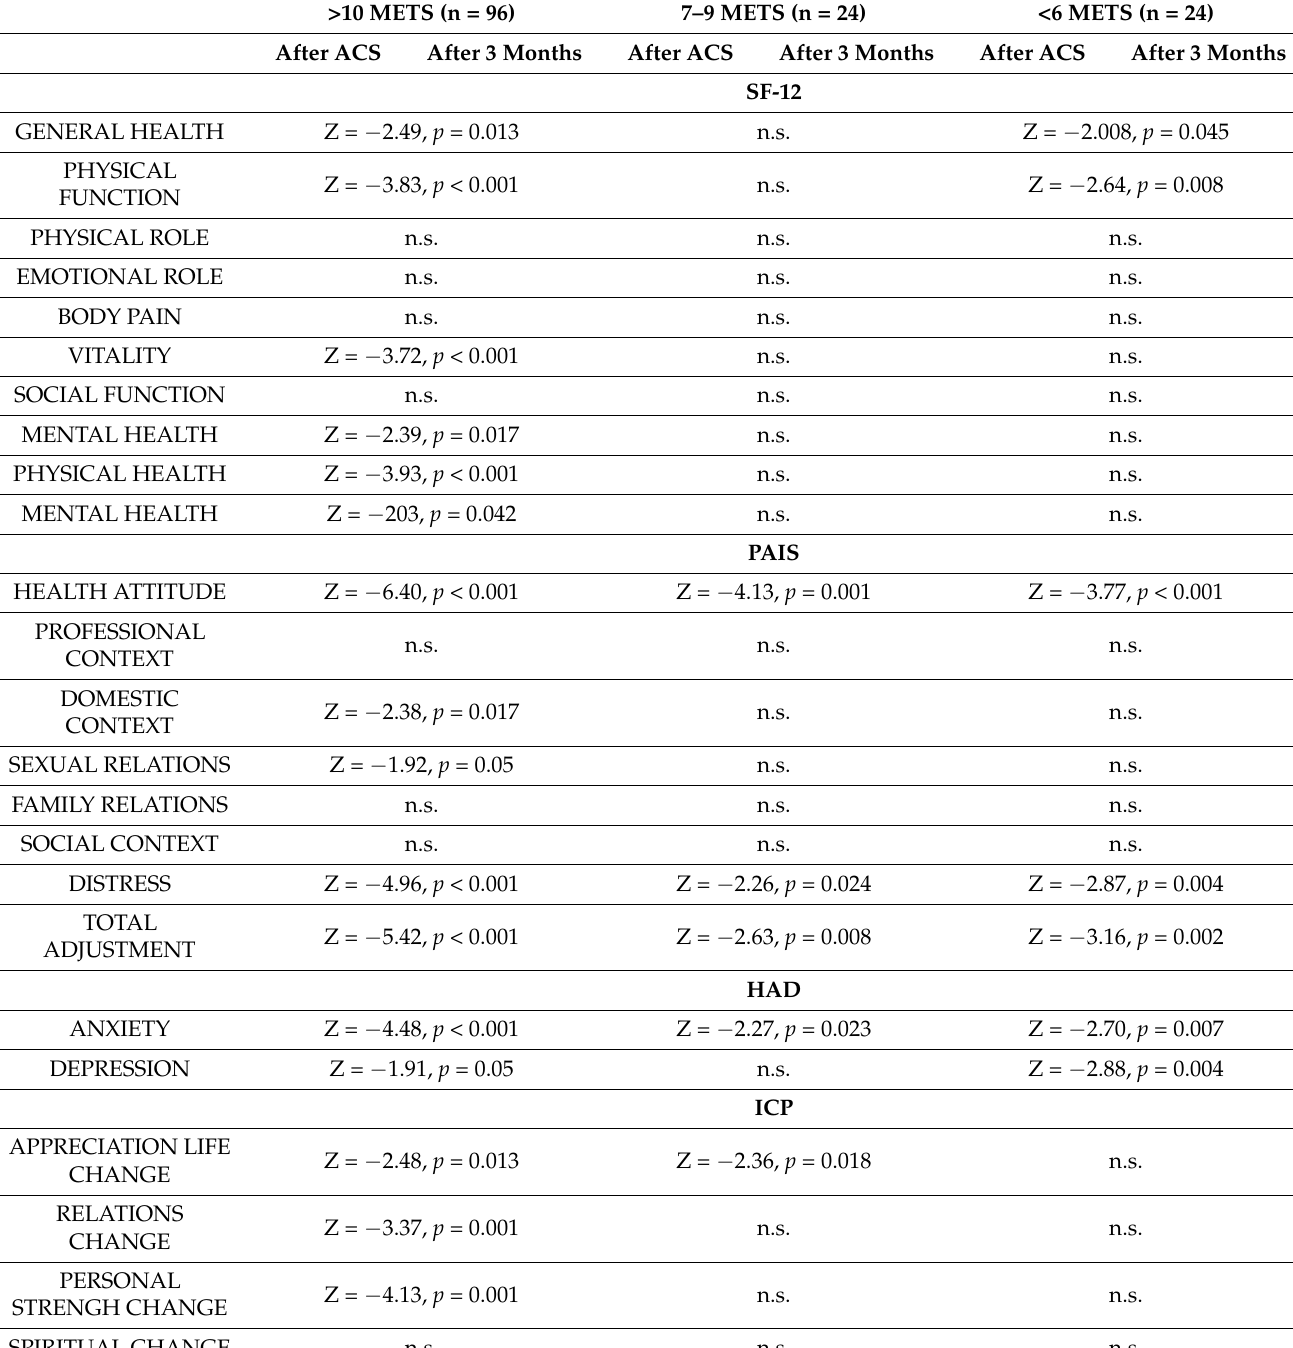
Table 3. Statistical differences between the measures at two times after ACS within each group.